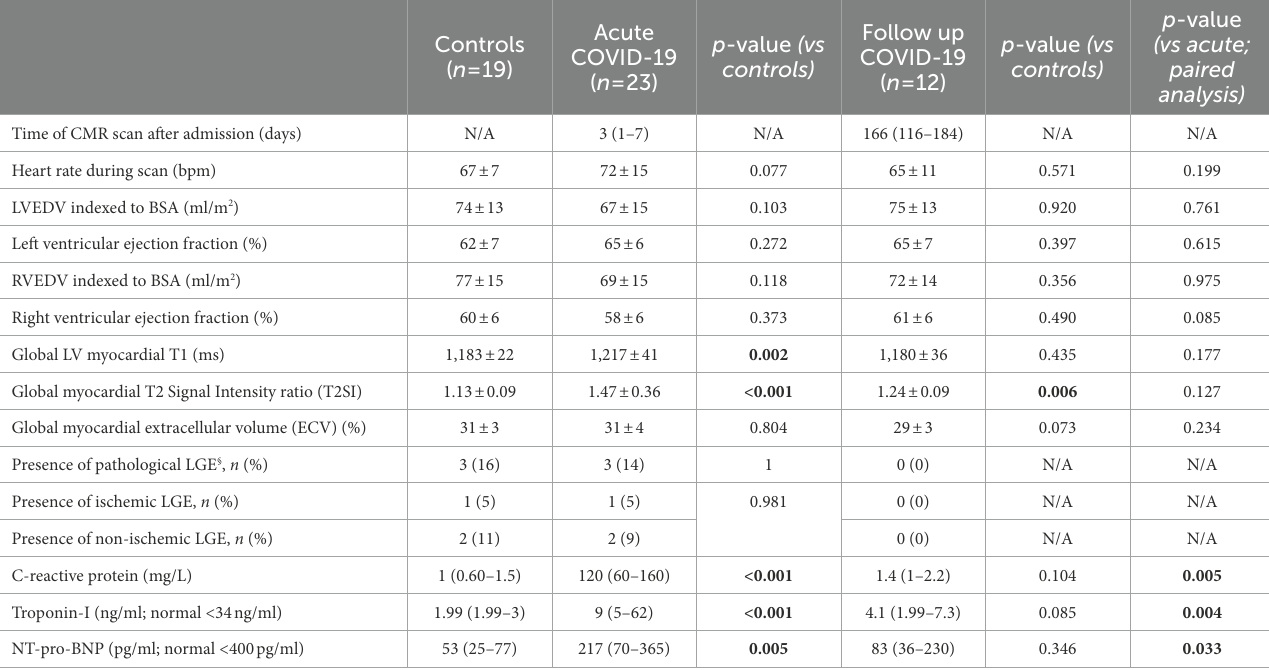
TABLE 2 CMR and blood test findings in controls, acute COVID-19 patients, and at follow up.